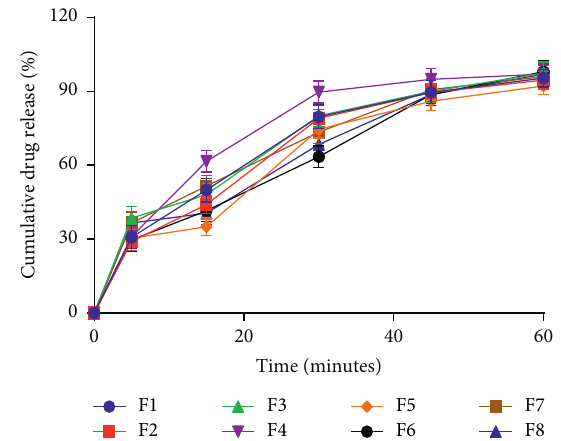
Figure 2: Drug release profile of formulated paracetamol tablets. The values are mean ± SD, n � 6.